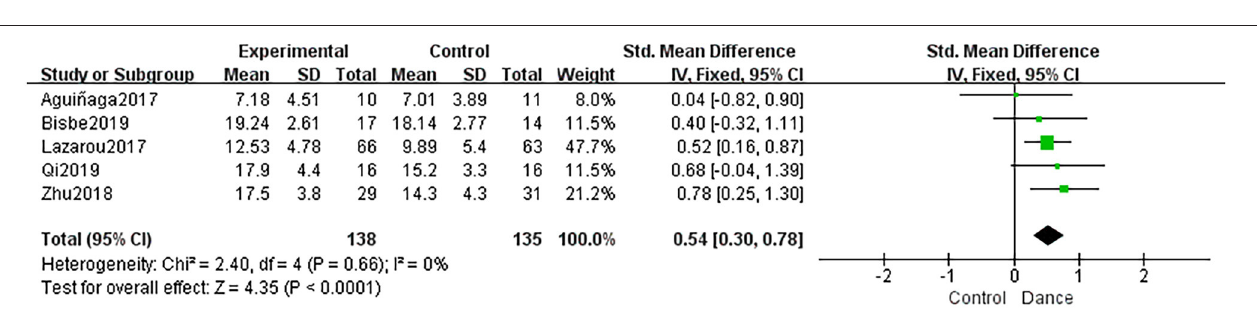
FIGURE 6 | Forest plot of executive function results of dance group vs. control group.